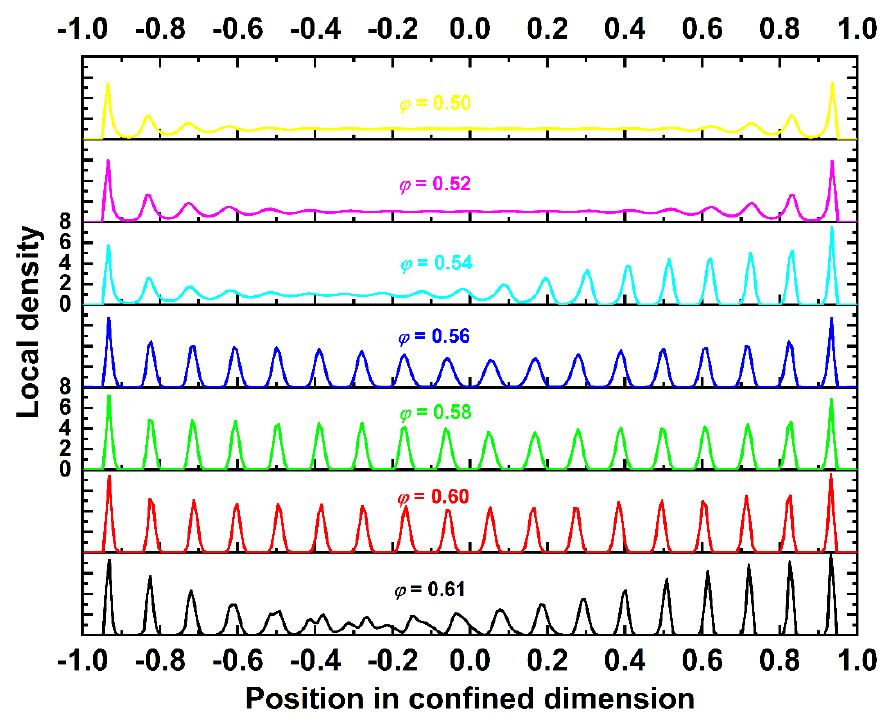
Figure 6. Stacked plots of local density versus the position in the confined ( x ) dimension for the N = 100 system. −1, 0, and +1 correspond to the positions of the bottom wall, center of the simulation cell, and top wall, respectively. Different plots correspond to different packing densities, ϕ . The coloring scheme follows that shown in Figure 3.